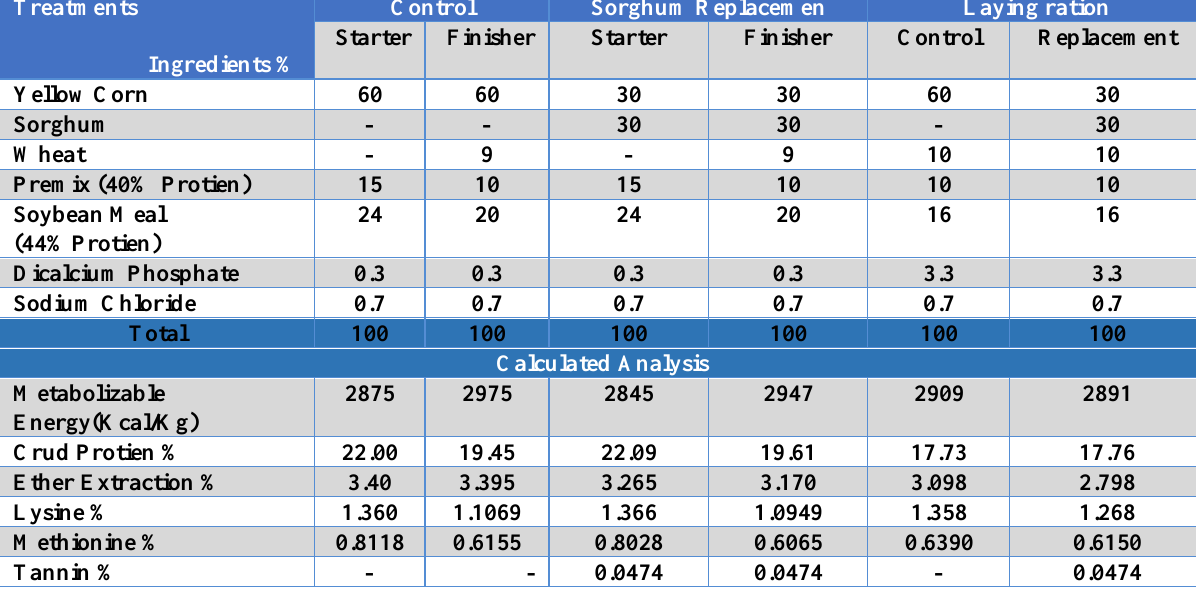
Table, 1: Composition and analyses of the experimental growing and Laying rations for quail, according to the nutritional requirements of NRC